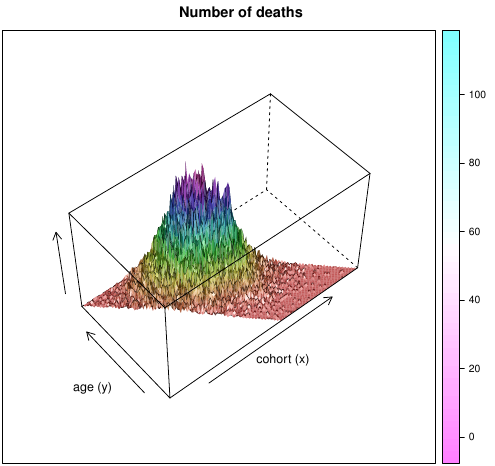
Figure 3. Histogram of the mesothelioma mortality data in UK from 1968 to 2016. The number of deaths are shown according to the cohort ( x ) and age of death ( y ), for periods ( x + y ) between 1968 and